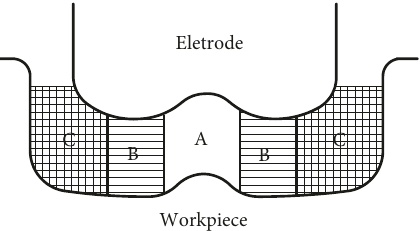
Figure 6: Graphic of three areas of the gap. A: the action area of ions; B: the combined action area of the ions and electrons; C: the electron action